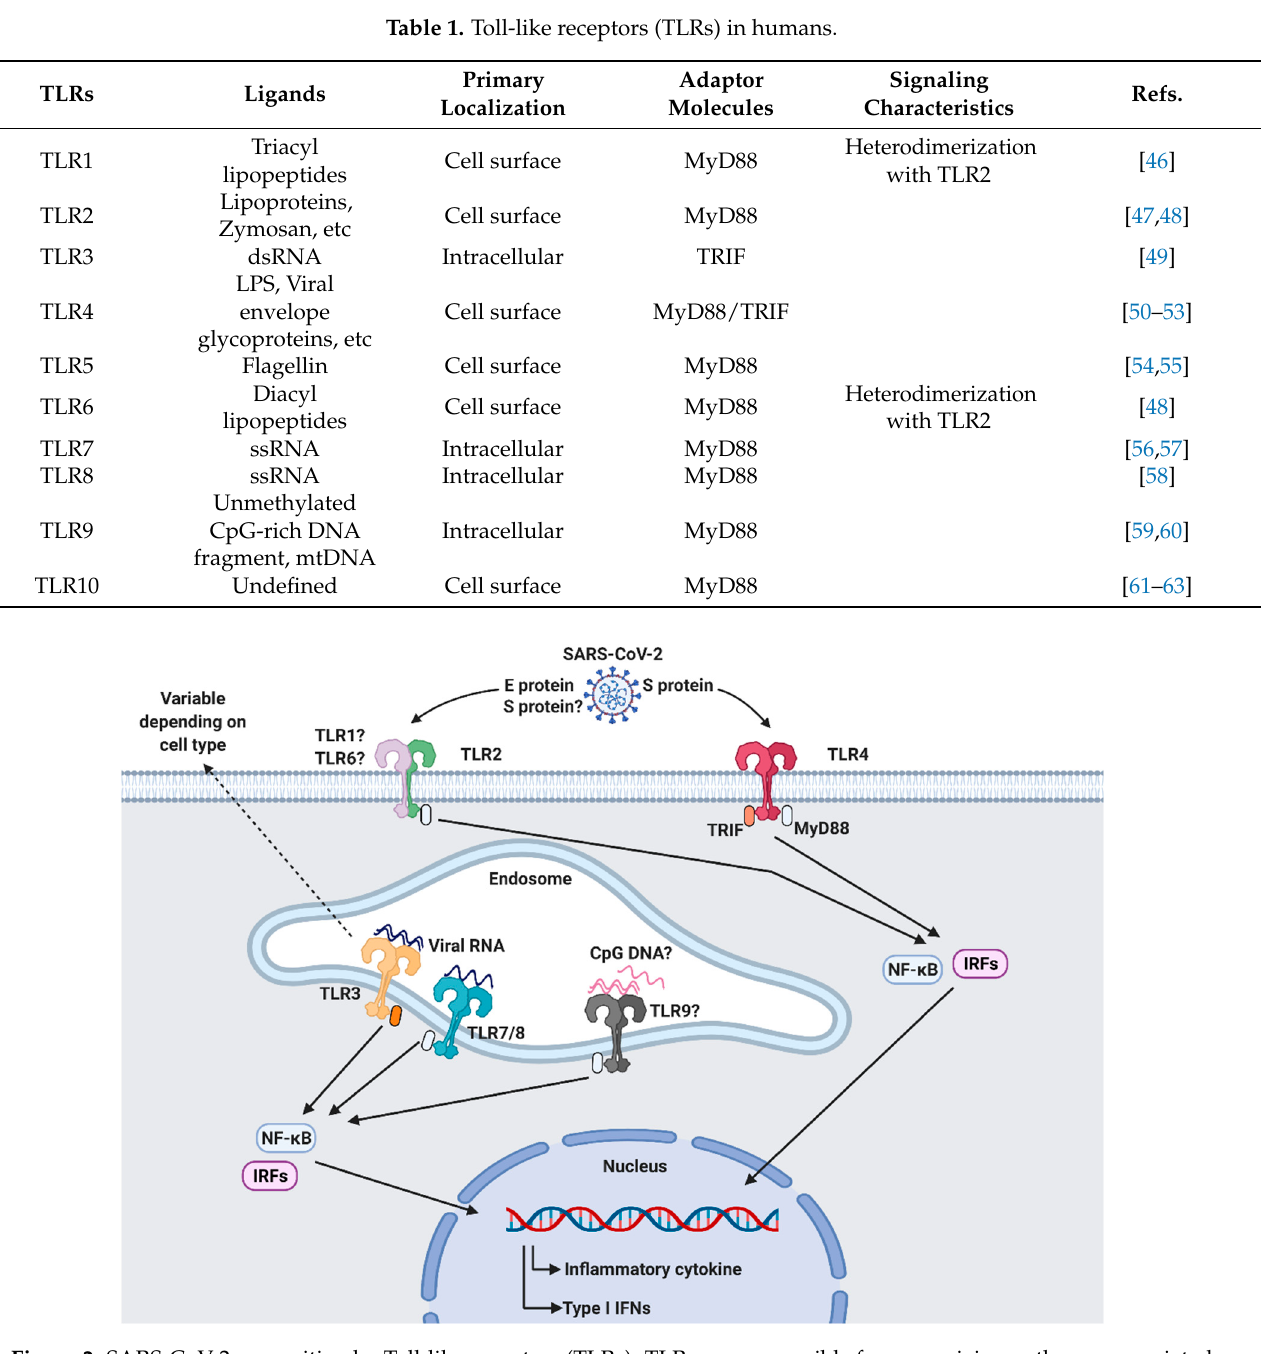
Figure 2. SARS-CoV-2 recognition by Toll-like receptors (TLRs). TLRs are responsible for recognizing pathogen-associated molecular patterns (PAMPs) derived from invading pathogens. Surface TLR2 and TLR4 and intracellular TLR3, TLR7/8, and TLR9 are thought to be involved in the sensing of SARS-CoV-2 infection. Activated TLRs initiate downstream signaling pathways by recruiting adaptor molecules, such as MyD88 and TRIF, which results in the subsequent production of inflammatory cytokines and type I IFNs through transcription factors NF- κβ and IRFs. This figure was created by BioRender.com accessed on 10 September 2021 (BioRender, Toronto, ON, Canada).